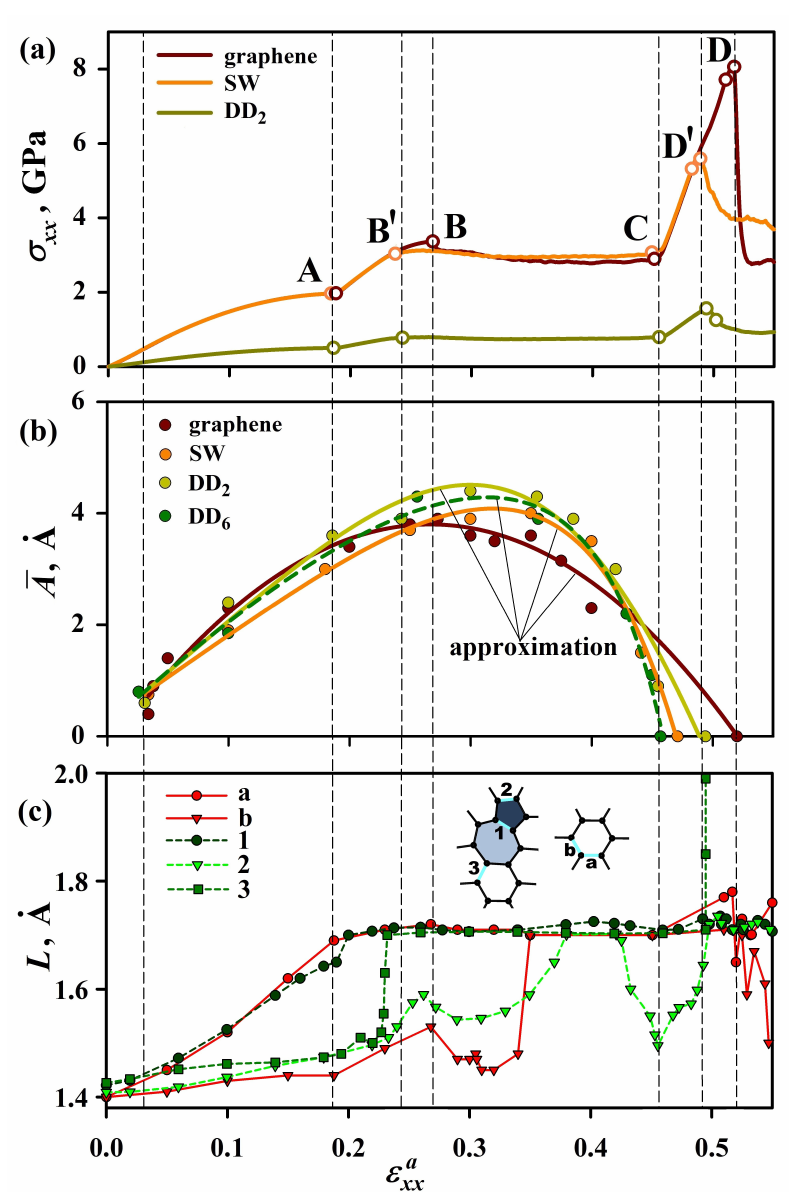
Figure 5. ( a ) Stress-strain curves for graphene, graphene with SW, and DD 2 under tension along armchair direction at T = 0 K. ( b ) Average amplitude A of ripples for defect-free graphene, graphene with SW, and DD 2 as the function of strain under tension along armchair direction at T = 0 K. Numerical data are shown by dots, while approximations are shown by solid lines. One more structure with the dipole (DD 6 ) is added for comparison with the approximation shown by a thick dashed line. The thin black dashed lines show different deformation regimes. ( c ) The bond length in graphene and graphene with DD 2 as the function of applied tensile